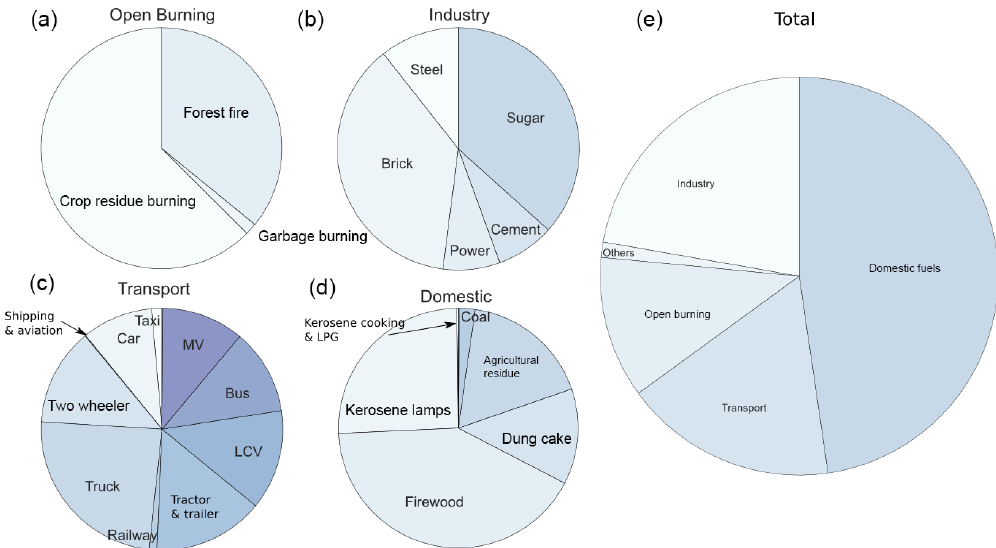
Figure 7. (a–d) Proportion of subcategories to the major sector emissions and (e) contribution of major sector emissions to the national emissions